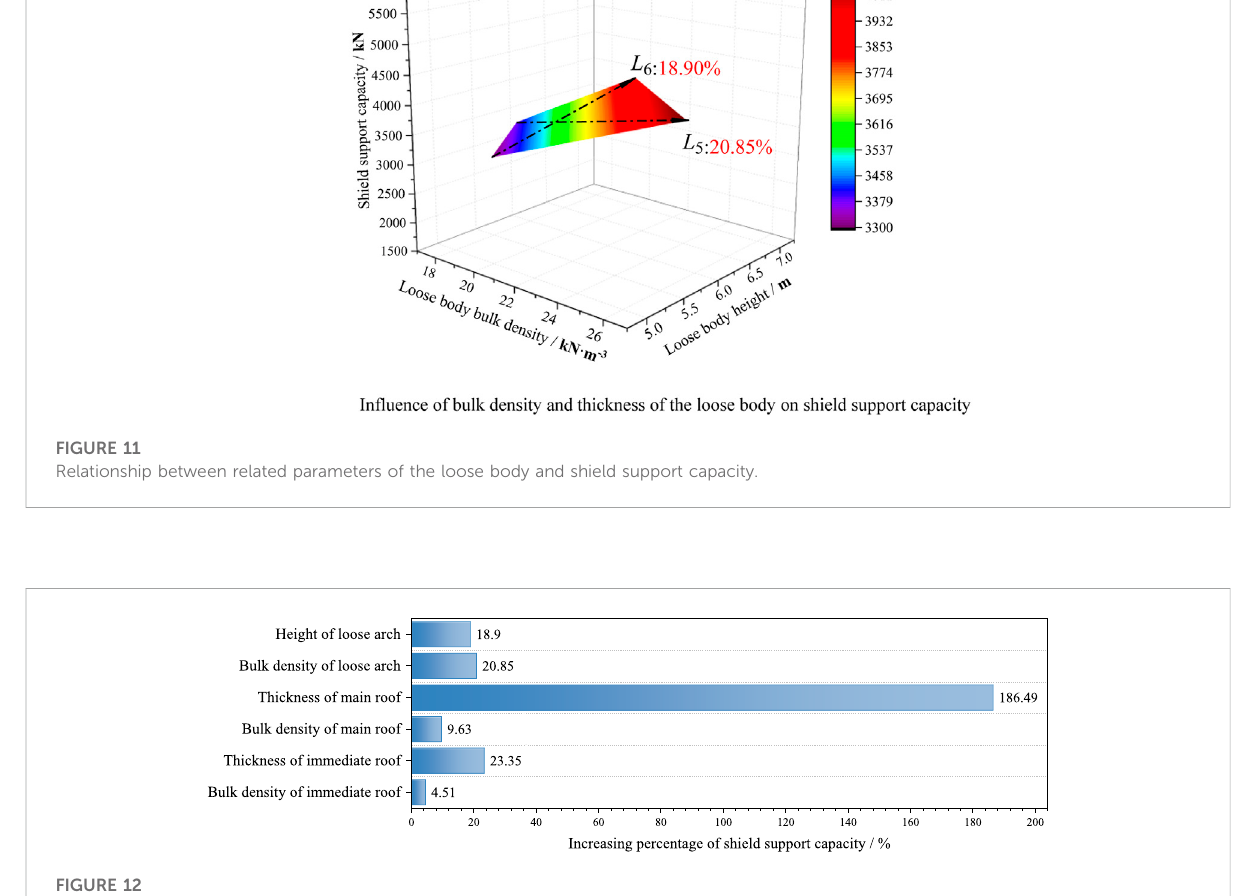
FIGURE 12 In fl uence degrees of various factors on the shield support